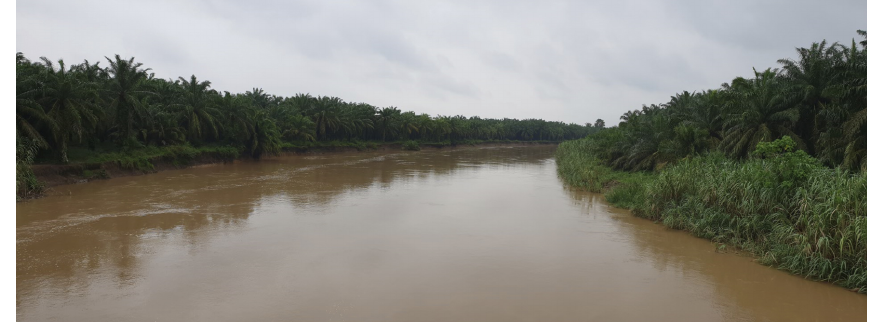
Figure A8. Smallholder oil palm planted right up to the river edge in Sumatra. These large areas of industrial-scale oil palm plantings are operated under smallholder licenses, potentially making it easier to bypass environmental legislation to prohibit the planting of oil palm within 50m of river banks (Foto: Erik